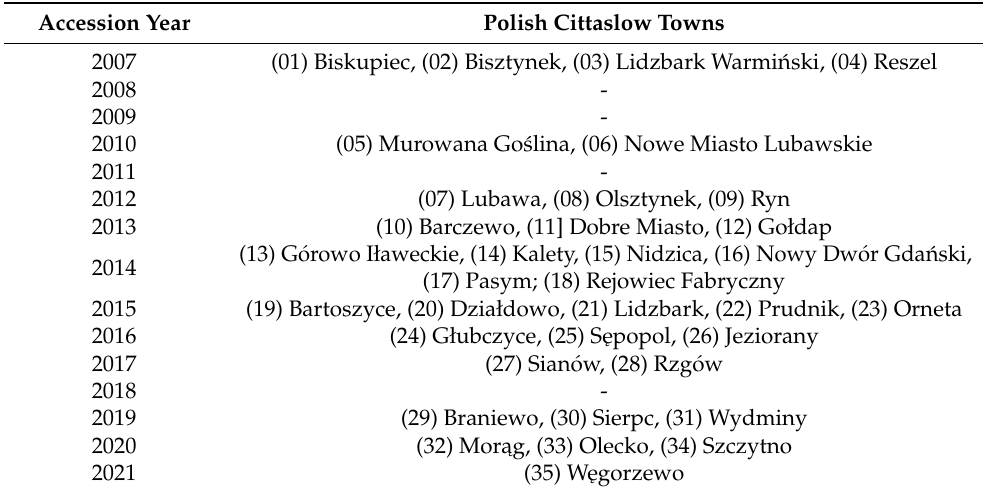
Table 1. Chronology of the accession of Polish towns to the Cittaslow